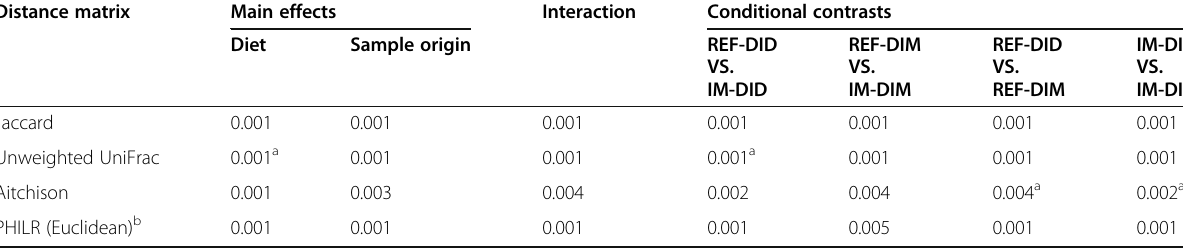
Table 2 PERMANOVA results and subsequent conditional contrasts Distance matrix